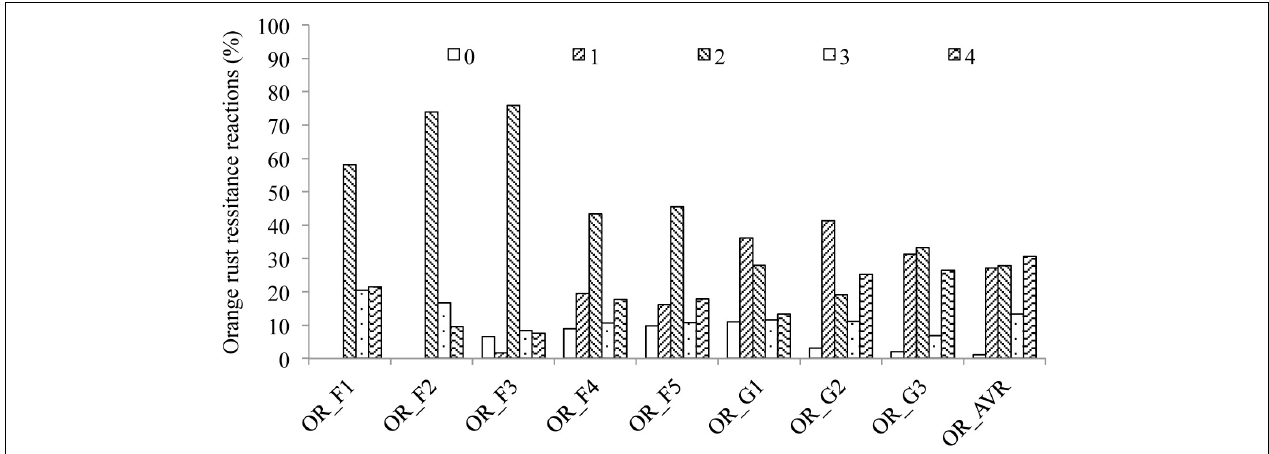
FIGURE 1 | Distribution of orange rust (OR) resistance reactions in the mapping population across multiple trials observations. F, Field; G, Greenhouse; AVR, average.